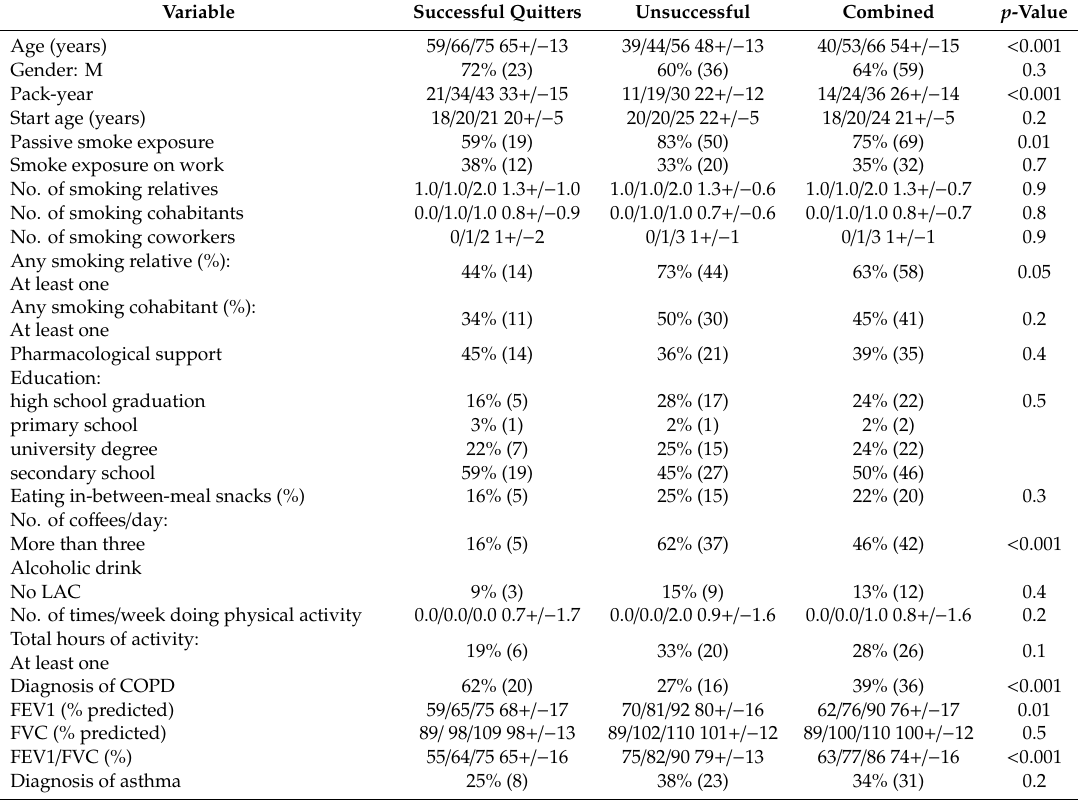
Table 4. Characteristics of patients with at least one previous attempt to quit smoking according to success or